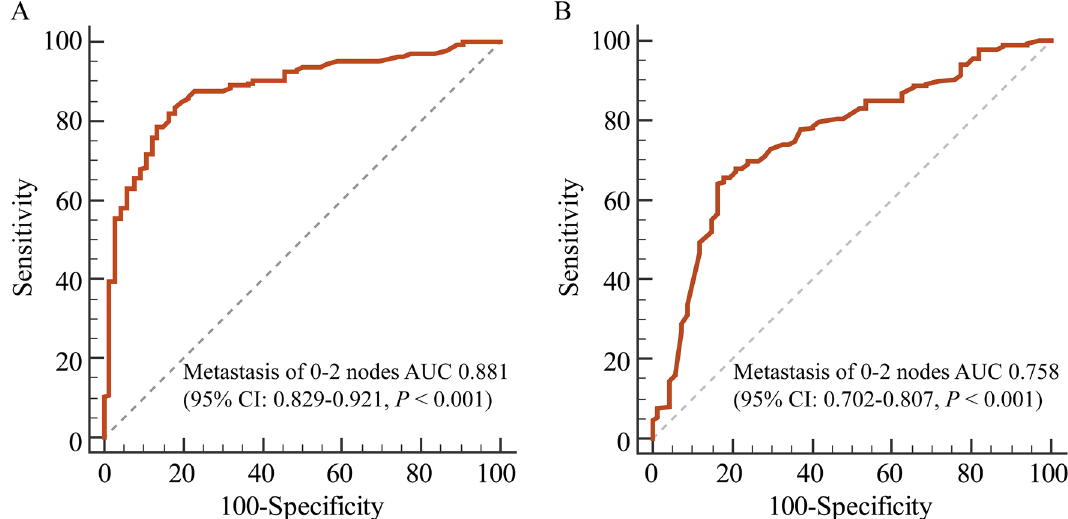
Figure 3. Receiver operating characteristic curve corresponding to the negative binomial regression model. ( A ) Area under the curve (AUC) for predicting 0–2 metastatic nodes in the modeling group. ( B ) AUC for predicting 0–2 metastatic nodes in the validation group. CI, confidence interval.